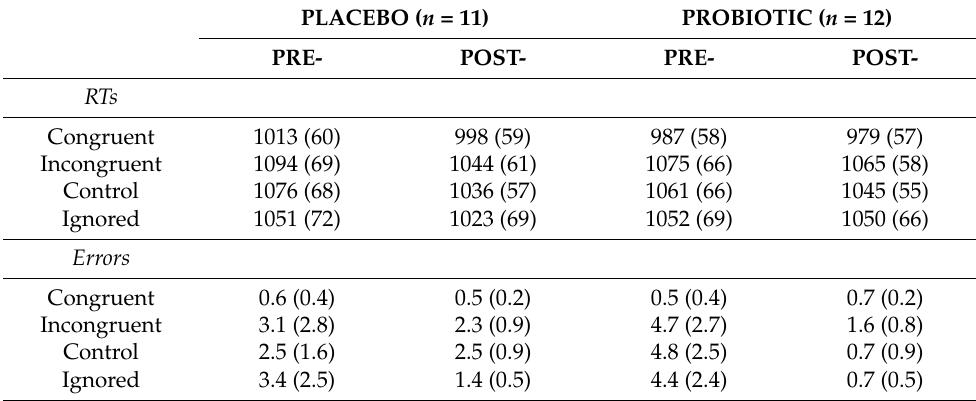
Table 6. The average median of RTs and errors expressed by mean and standard